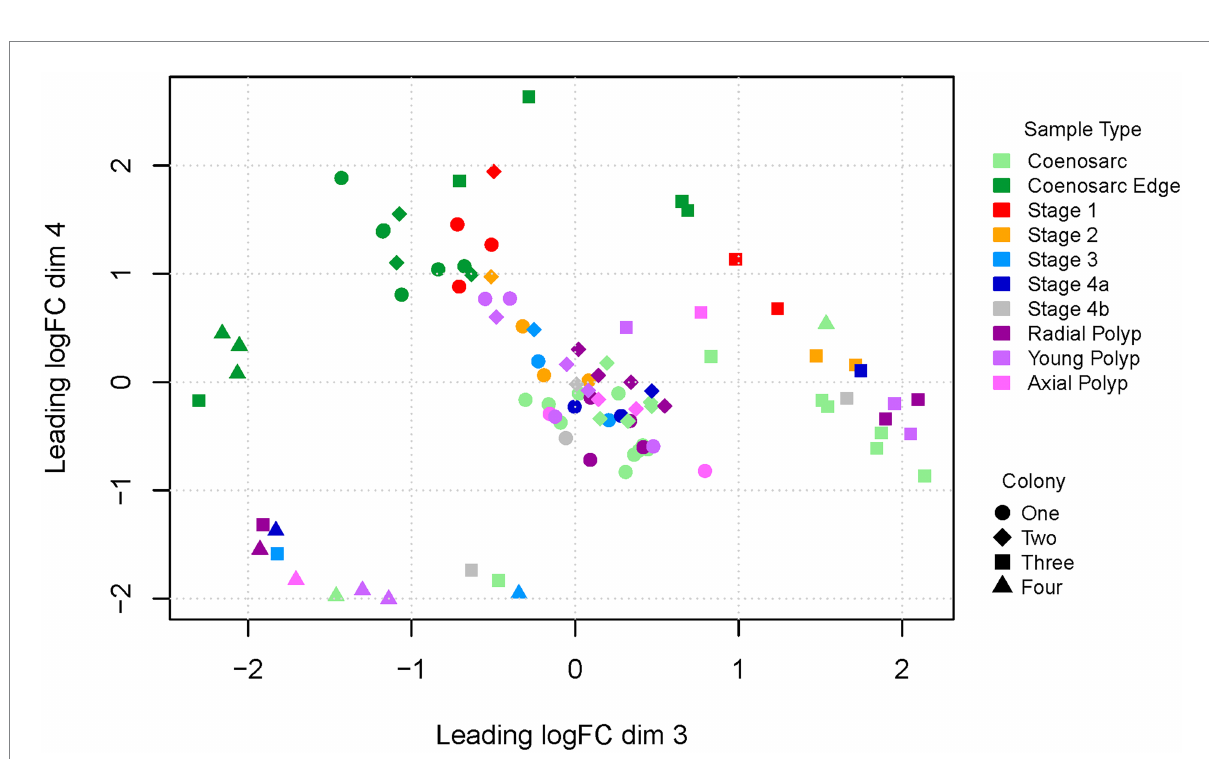
FIGURE 3 Multi-dimensional scaling plot (dimensions 3 and 4) of RNA-Seq samples representing regeneration of A. millepora . Colony one and two were housed in a closed system in Canberra, colony three and four were from open system in Orpheus Island. Note intermingled regeneration stage 1 and coenosarc edge samples segregating from other samples in dimension 4.